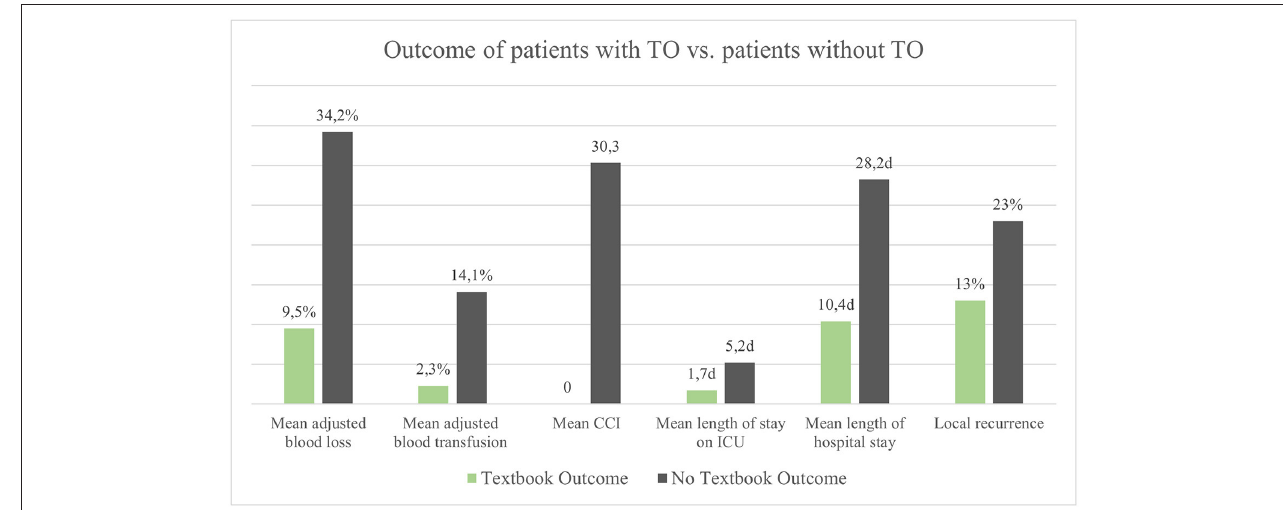
FIGURE 2 | Comparison of outcomes of patients with TO vs. patients without TO; d, days.